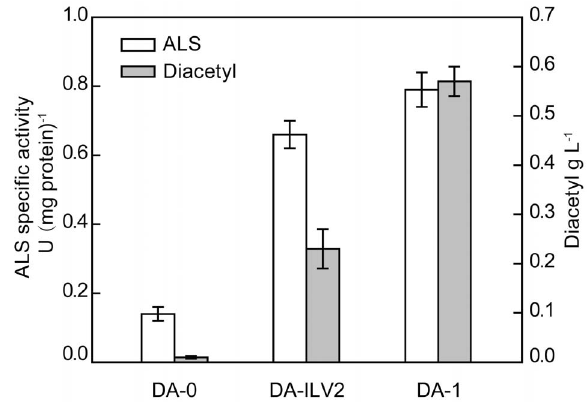
Figure 2. Evaluation of ALS activity and diacetyl production using different ALS enzymes. The ALS activities were determined in cells at mid-log growth phase of batch-flask fermentation. The mean values of three independent experiments are shown. The error bars indicate the respective standard deviations.